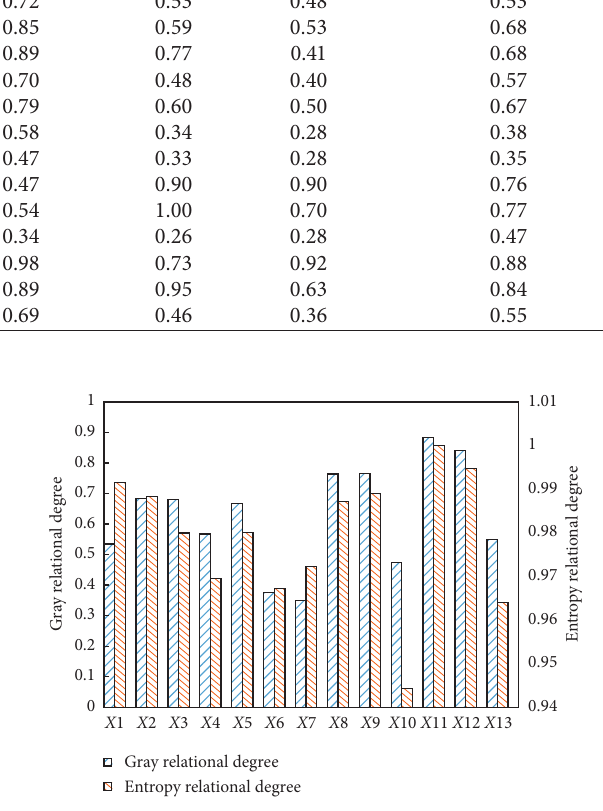
Figure 5: Gray relational degree and entropy relational degree between asphalt indexes and